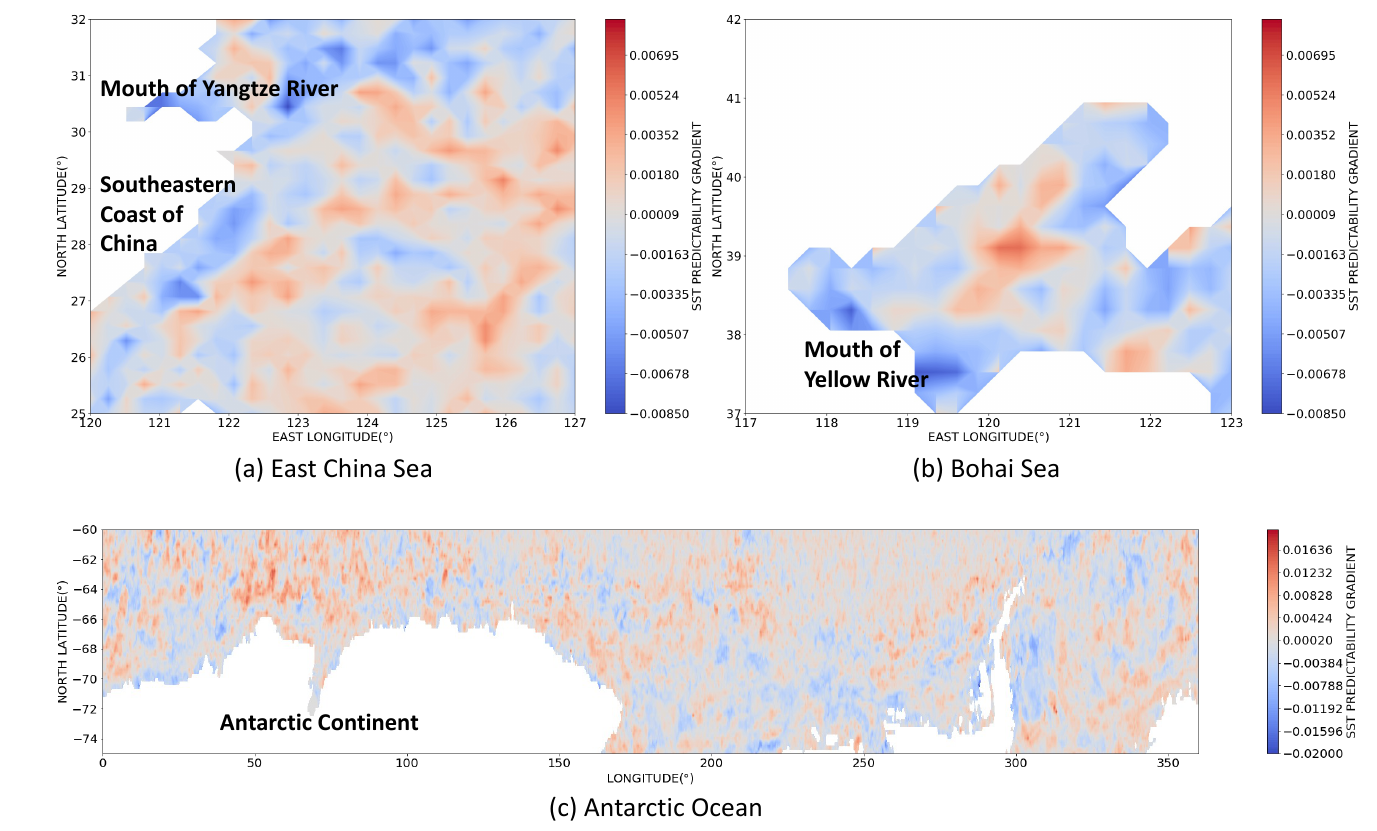
Figure 18. The gradient of the SST predictability in ( a ) the East China Sea, ( b ) the Bohai Sea and ( c ) the Antarctic Ocean.